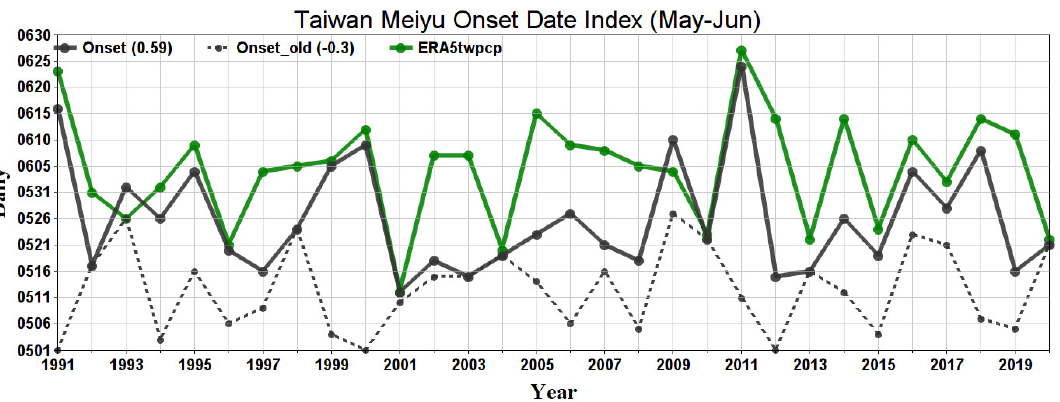
Figure 6. Time-series of onset dates defined by older criteria (dot line), newer criteria (black solid line), and the precipitation maximum (green solid line). The correlation coefficient is between ERA5twpcp and Onset, Onset_old index.